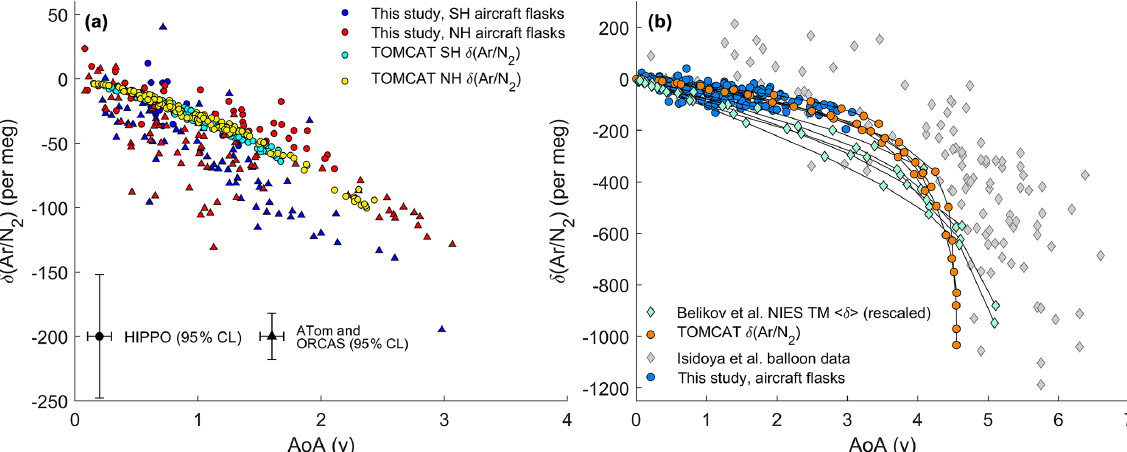
Figure 4. Comparison of age of air (AoA) and gravitational settling (GS) of δ( Ar / N 2 ) in models and observations. Panel (a) shows ob- servations from the Northern Hemisphere (red) and Southern Hemisphere (blue) together with TOMCAT model output (SH: cyan; NH: yellow) selected from the closest model grid box in time and space. Because uncertainty for AoA is similar for all stratospheric samples but δ( Ar / N 2 ) uncertainty differs between campaigns, representative error bars (95% confidence interval) are shown for HIPPO (triangles) and ATom/ORCAS (circles) at an arbitrary AoA. δ( Ar / N 2 ) is normalized to yield a delta value of zero in the equatorial free troposphere. In panel (b) , observations from airborne campaigns (this study) and the balloon sampling system (Ishidoya et al., 2008, 2013, 2018; Sugawara et al., 2018) are plotted with the AoA–GS relationship observed in TOMCAT and the NIES TM (Belikov et al., 2019) as lines for each of the latitude bands shown in Fig. 5 and points for different altitude bins between 10 and 35km. To yield an equivalent estimate of δ( Ar / N 2 ) , δ( 13 CO 2 / 12 CO 2 ) results from the NIES TM (Belikov et al., 2019) have been rescaled according to Eq. (5) and offset by ∼ 10 per meg to account for the different tropospheric reference region in the definition of δ